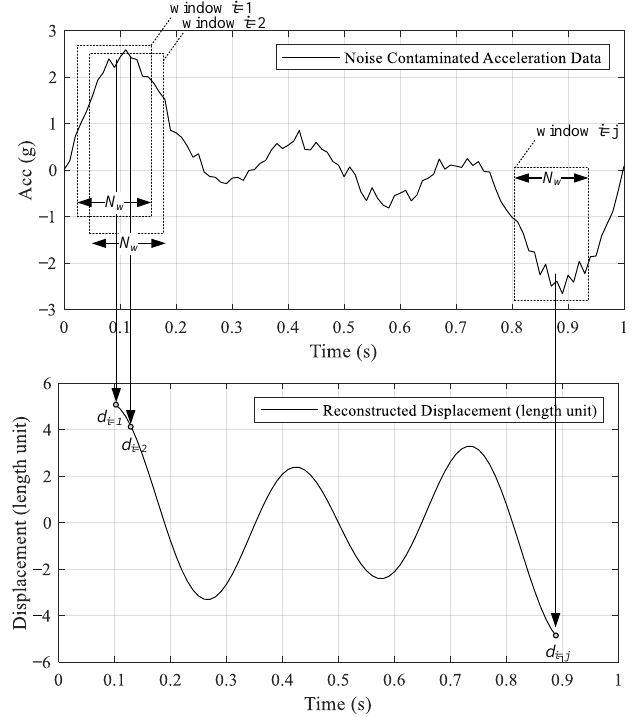
Figure 1. Illustration of displacement reconstruction scheme.